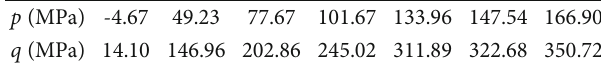
Table 2: p and q under di ff erent test